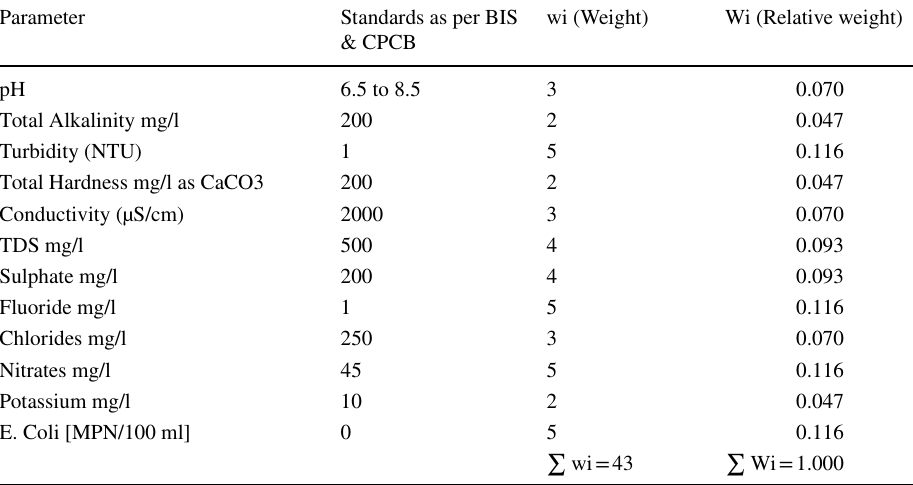
Table 1 Showing weight assigned and relative weight calculated for selected